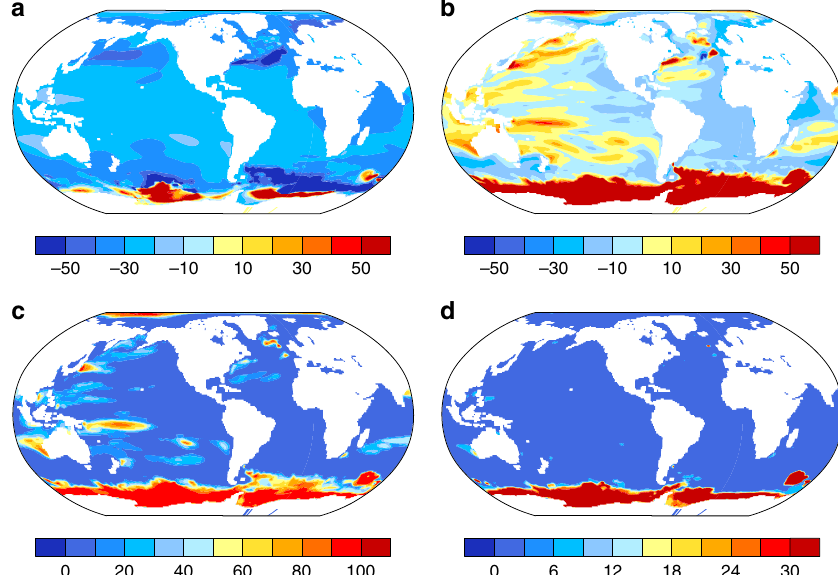
Fig. 4 Ratio of the SLR decadal trend between RCP4.5 and RCP8.5 ensembles. a The ratio between the ensemble mean SLR decadal trend in RCP4.5 and RCP8.5 calculated as the difference (RCP4.5 minus RCP8.5) relative to the RCP8.5 value. b The ratio between the maximum SLR decadal trend at each grid point in RCP4.5 ensemble and the minimum SLR decadal trend at each grid point in RCP8.5 ensemble. c The percentage chance that the maximum SLR trend at each grid point in RCP4.5 ensemble is greater than the minimum SLR trend at each grid point in RCP8.5 ensemble. d The percentage chance that the maximum SLR trend at each grid point in RCP4.5 ensemble is greater than the ensemble mean SLR decadal trend in RCP8.5